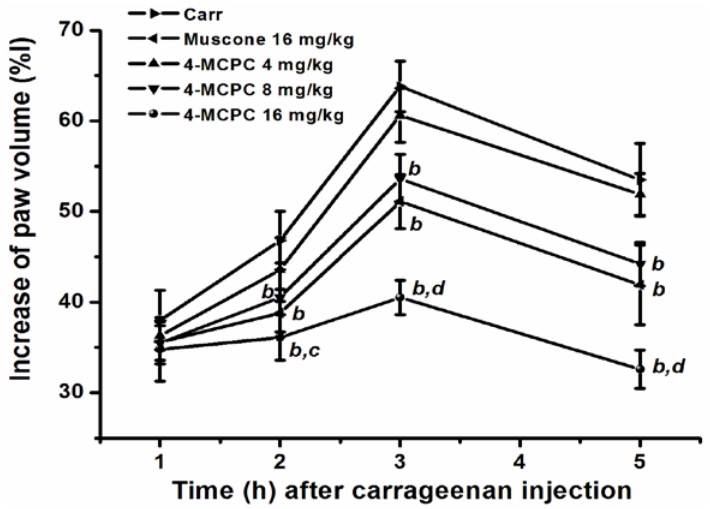
Figure 2. Effects of 4-MCPC on carrageenan-induced mouse paw edema. Treatment with 4-MCPC (8 and 16 mg/kg) and muscone (16 mg/kg), respectively, reduced paw edema at 2, 3 or 5 h after carrageenan injection. For each group, n = 10. b p < 0.01 versus carrageenan model group; c p < 0.05; d p < 0.01, versus muscone group. Carr: carrageenan.